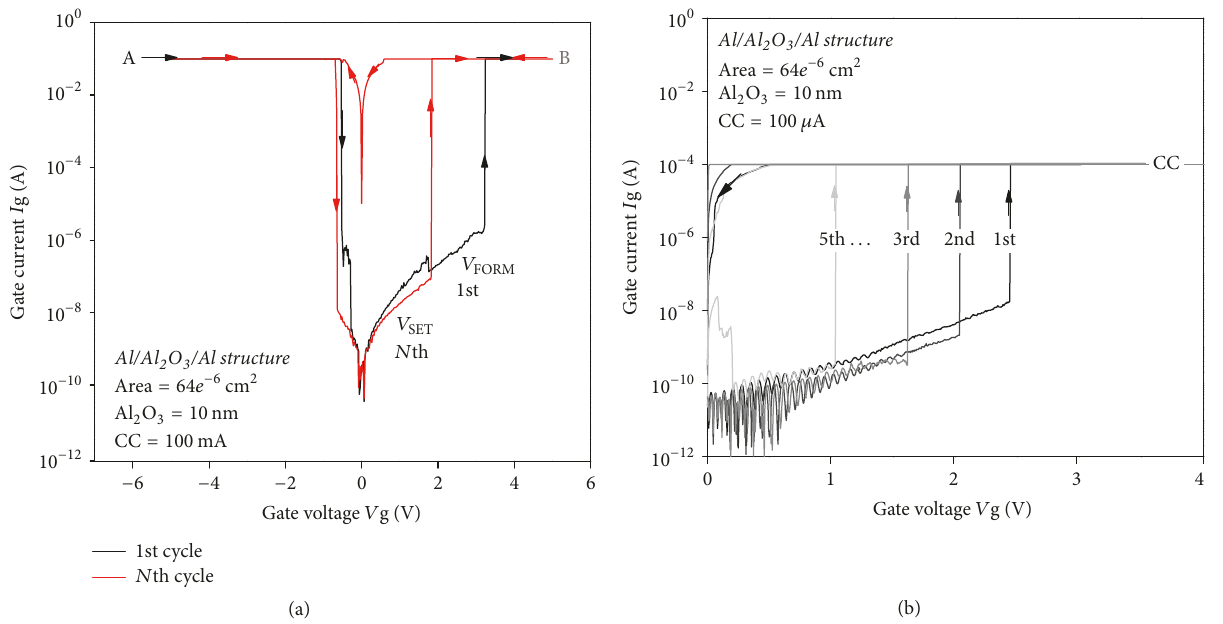
Figure 6: Resistive switching for annealed Al/Al 2 O 3 (10nm)/Al stacked structures. (a) Bipolar mode with CC = 100 mA and (b) unipolar mode with CC SET = 100 𝜇 A. The 𝐼 OFF /𝐼 ON ratio for these structures is 10 4 –10 6 for both operation modes. For the unipolar mode, a decrease in 𝑉 SET is observed during continuous resistive